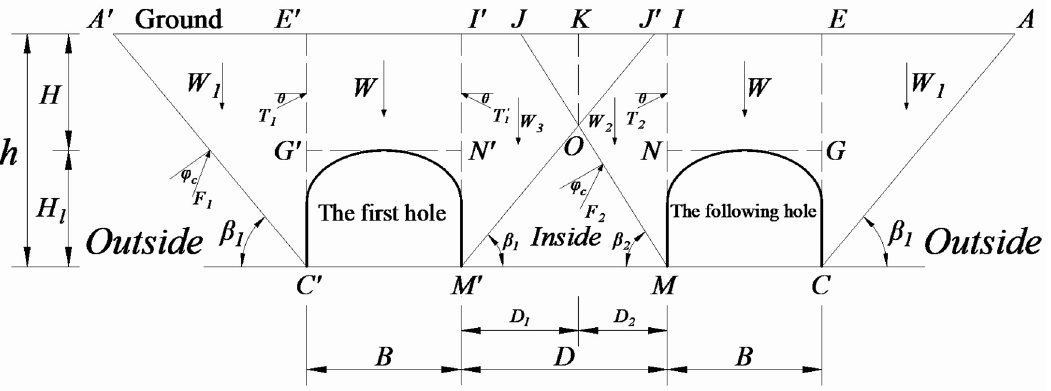
Figure 8. Theoretical sliding failure mode and calculating load schematic diagram.